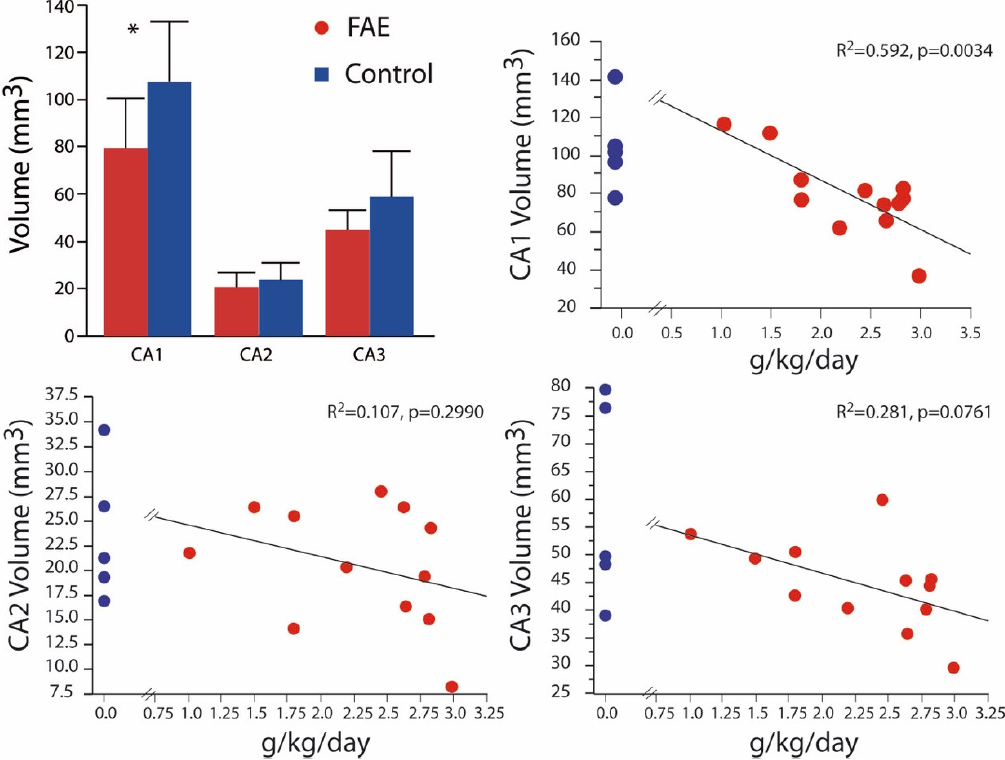
Figure 3 . Hippocampal Volume Volumetric differences were isolated to the CA1 with the expanded analysis that includes low FAE-exposed subjects. Volume was negatively correlated with daily exposure in the CA1 region only. Control values are shown for each correlation graph for illustration purposes only as they were not incorporated in the correlational analysis. * p < 0.05 FAE vs. control.